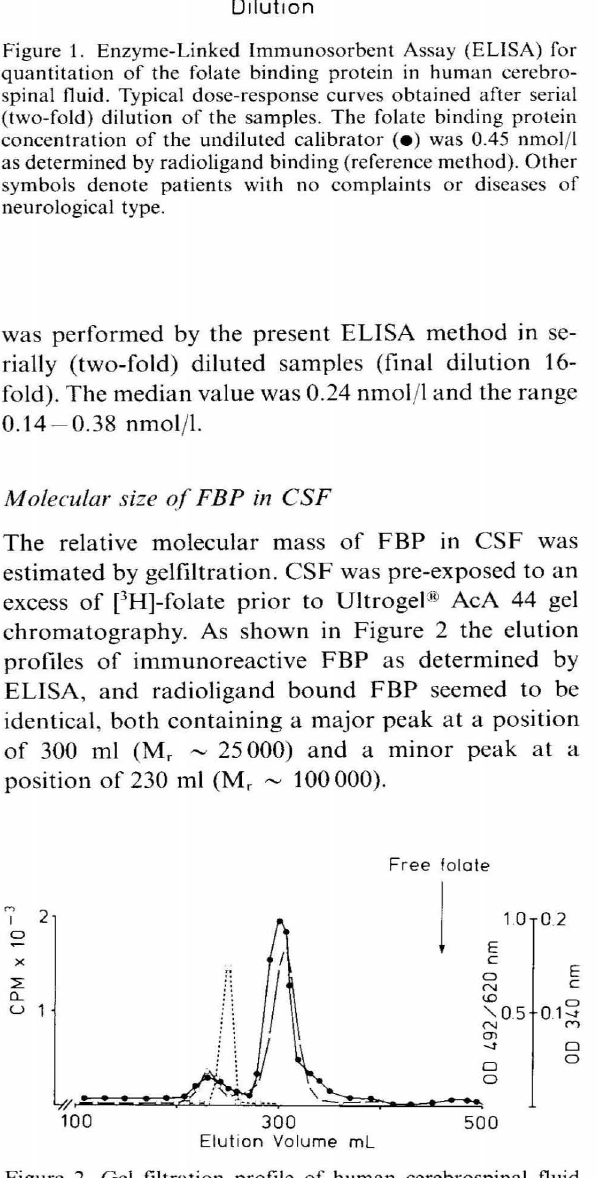
Figure 2. Gel filtration profile of human cerebrospinal fluid which had been incubated with [3H]-folate prior to chromatog raphy (UltrogeJ AcA 44). For further details, cf. text. Left ordinate, counts per minute in the effluent (cpm, e). Right ordinate. immunoreactive folate binding protein in the effluent (0 ) determined by ELISA (00 492/620 nm), and albumin in the effluent (D) monitored by an immunoturbidimetric method (00340